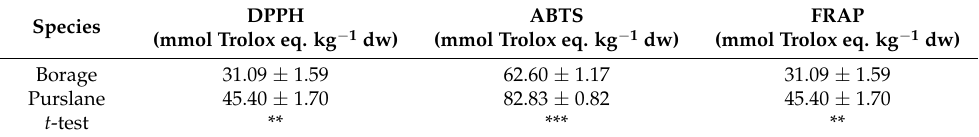
Table 3. Antioxidant activities in microgreen extracts. Means were statistically separated using a two-tailed Student’s t -test. **: p < 0.01; ***: p < 0.001.